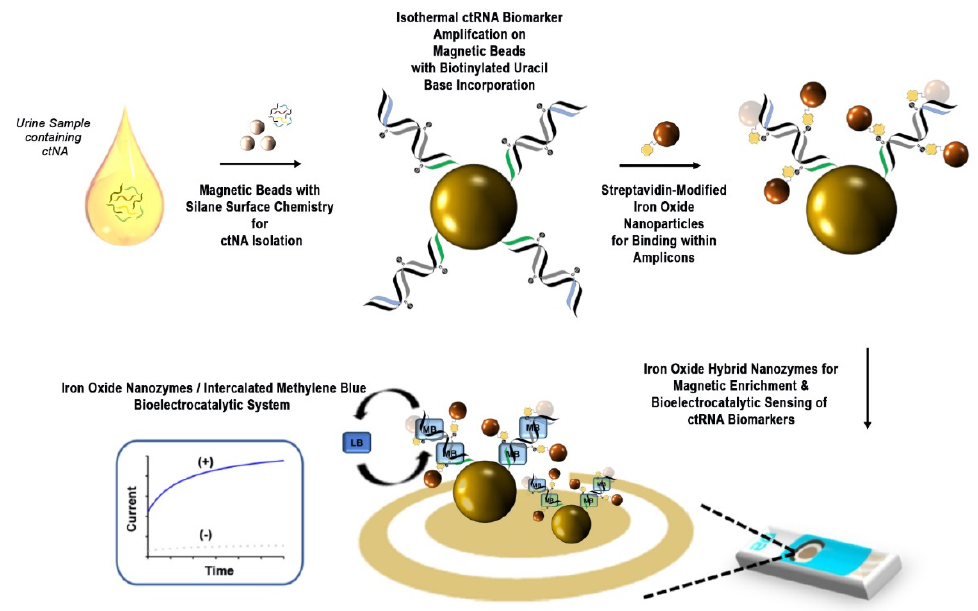
Figure 1. Schematic for using streptavidin-modified iron oxide nanozymes for urinary ctRNA magnetic enrichment and bioelectrocatalytic